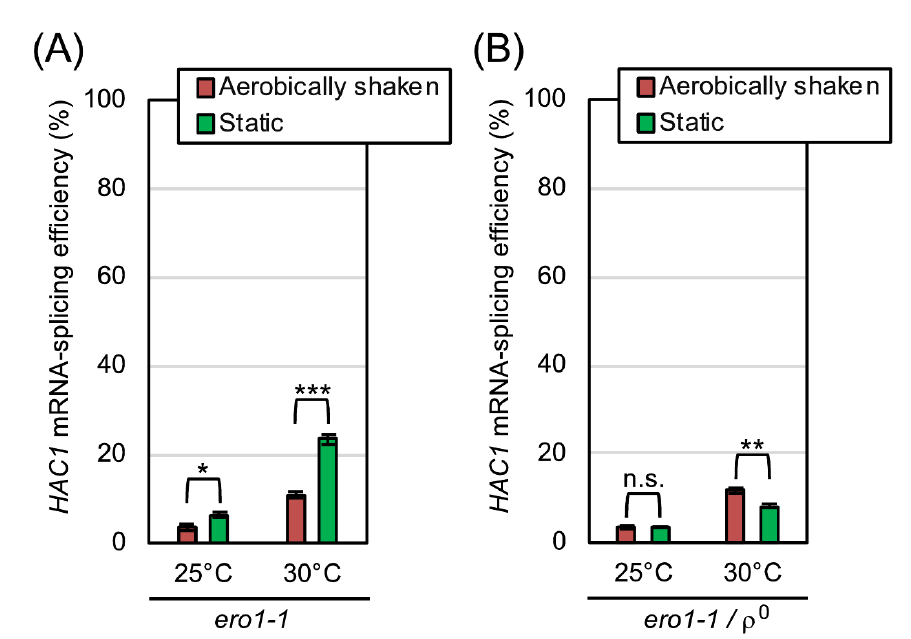
FIGURE 7: ER-stress induced by the ero1-1 mutation is alleviated by aerobic agitation dependently on mitochondrial respiration. After being pre- cultured at 25°C in